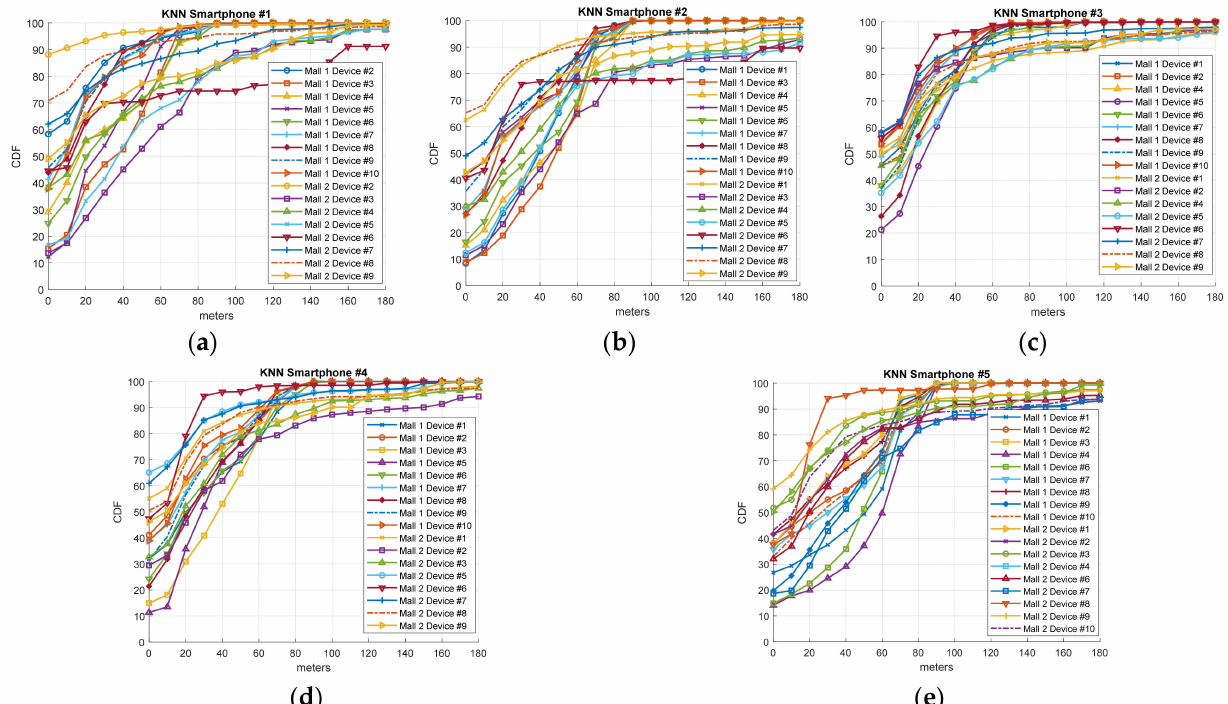
Figure 8. CDF referring to the accuracy of the IPS generated with KNN on day 74 for mall #1 and day 60 for mall #2